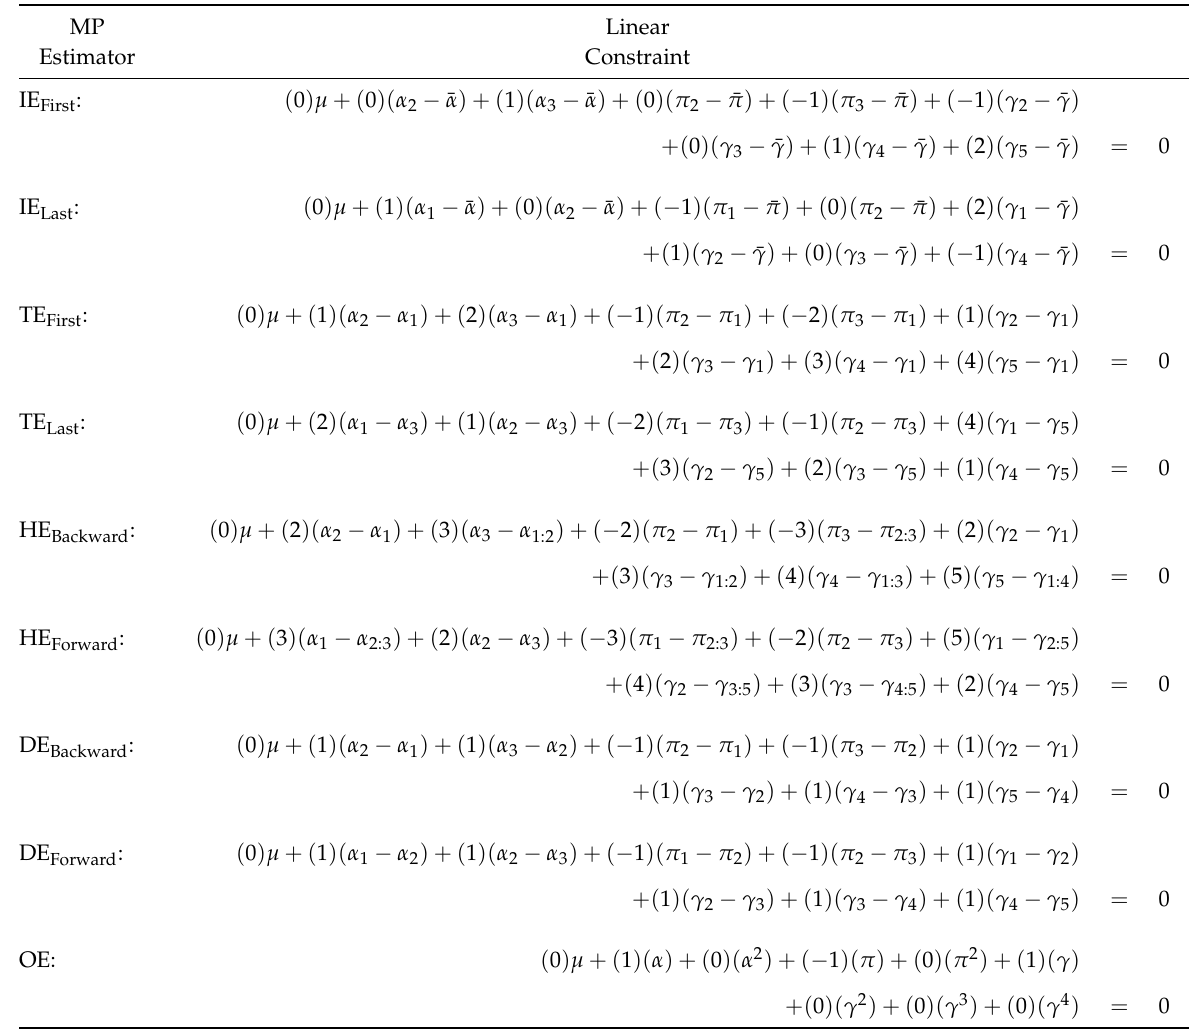
Table 1: Linear constraints of MP estimators with I = 3 and J = 3 groups.